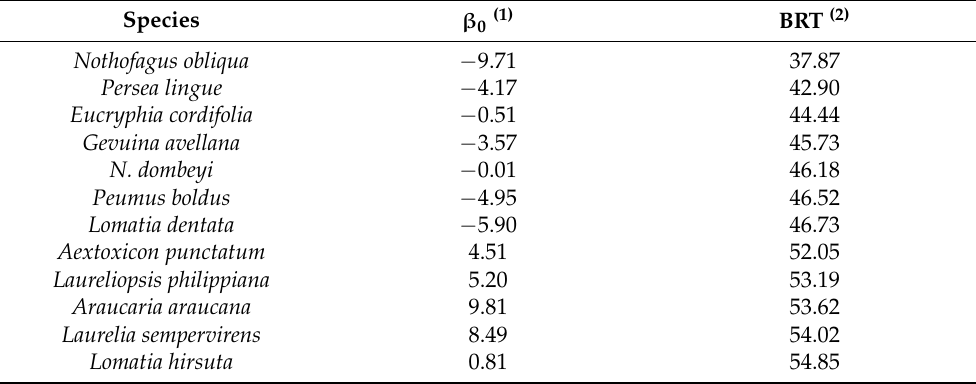
Table 4. Marginal effects of the species on the predictions in the intercepts of the mixed model (1) and on the marginal overall effects of the boosted regression trees